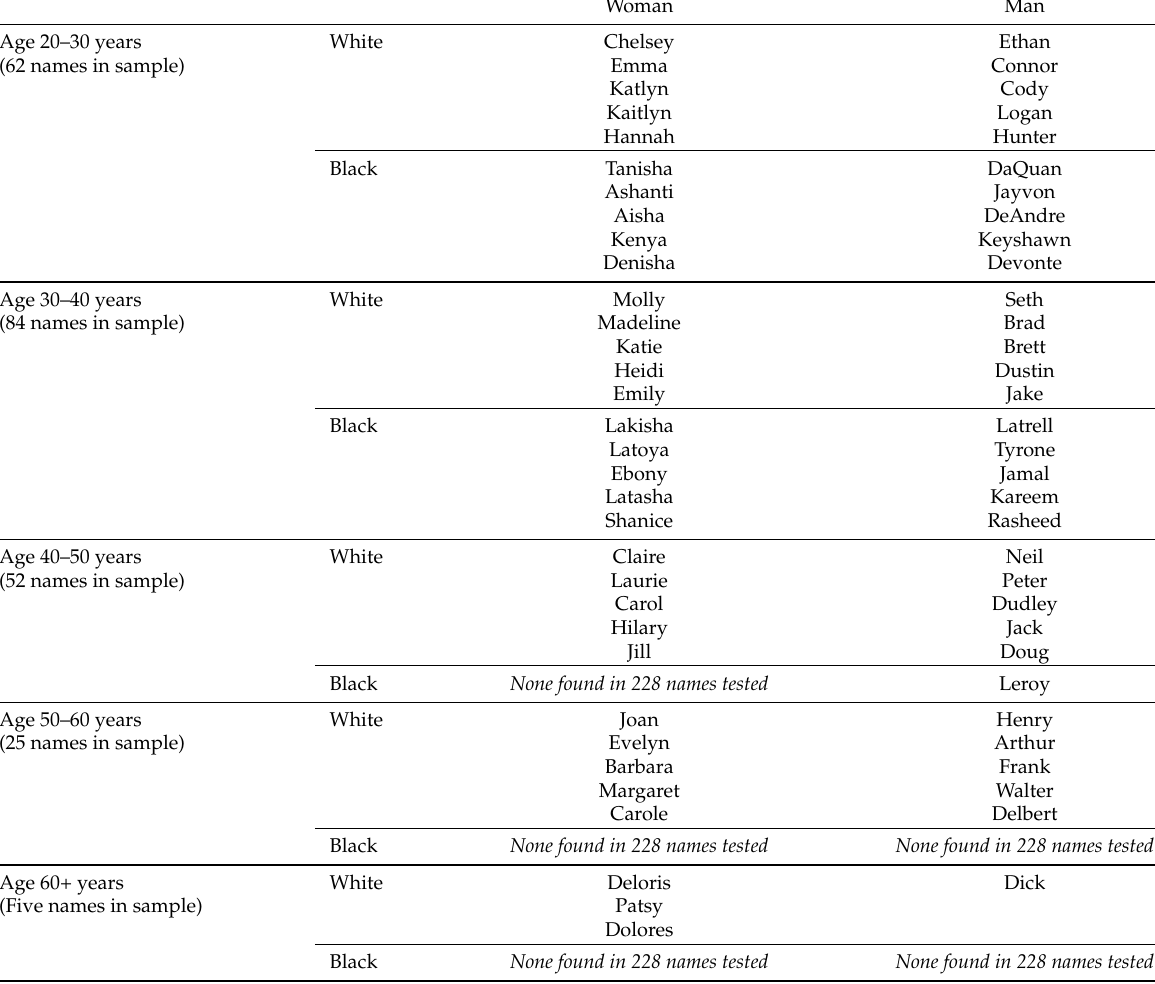
Table 5: Top five names that signal combined age, gender, and race